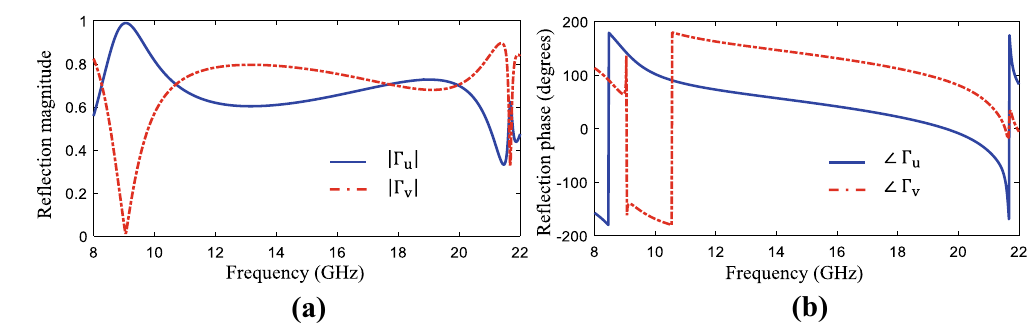
Figure 8. Reflection coefficient ( a ) amplitude and ( b ) phase of the optimized polarization converter